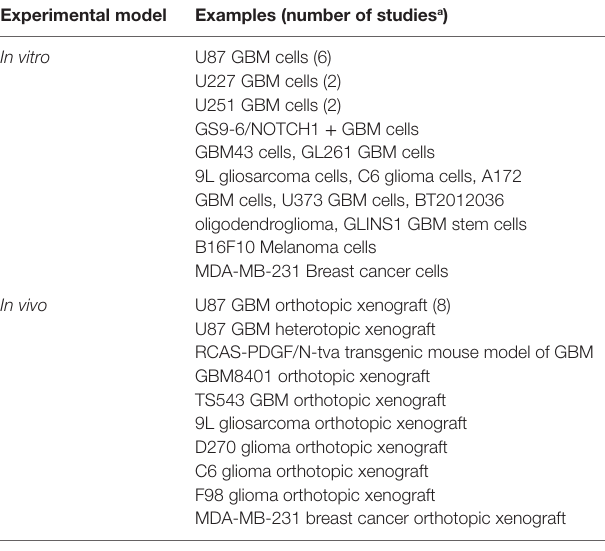
taBLe 4 | Imaging techniques applied in conjunction with gold nanoparticles (GNPs) for brain tumor diagnosis.